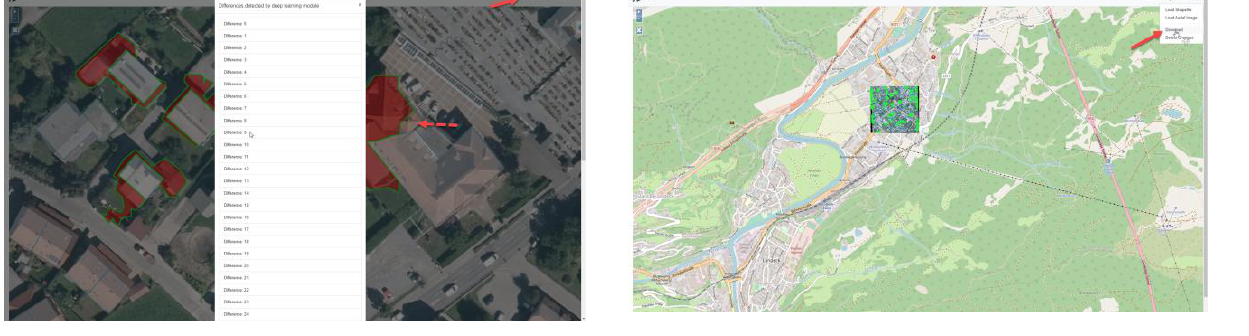
Figure 13. An overview of DL segmentation result on the test image and vector download menu for the updated vector